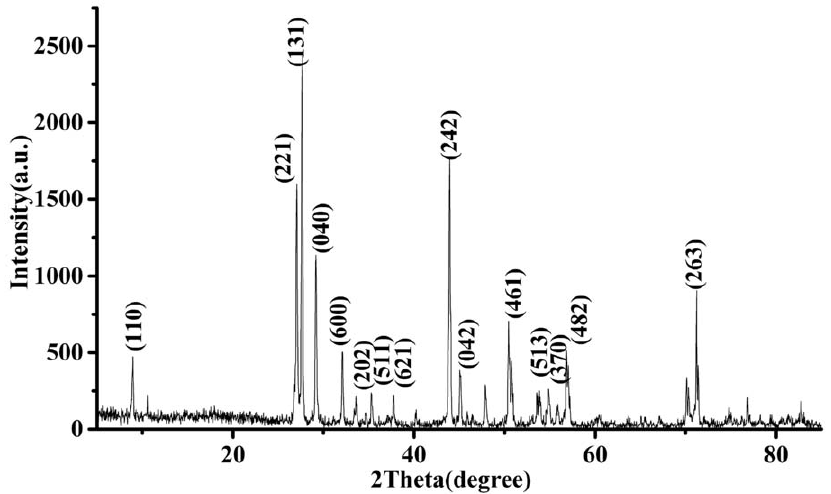
Figure 2. XRD pattern of Yb 3 + :KBaGd(MoO 4 ) 3 crystal at room temperature.